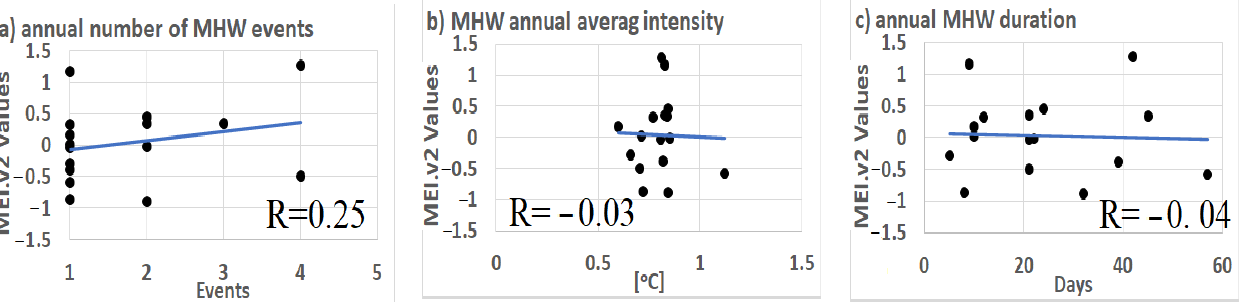
Figure 7. Annual time series of the Indian Summer Monsoon Index (ISMI) over 1982–2019 are shown in primary axis. In the secondary axis and in red color, intensity, duration and frequency are shown in ( a – c ), respectively.